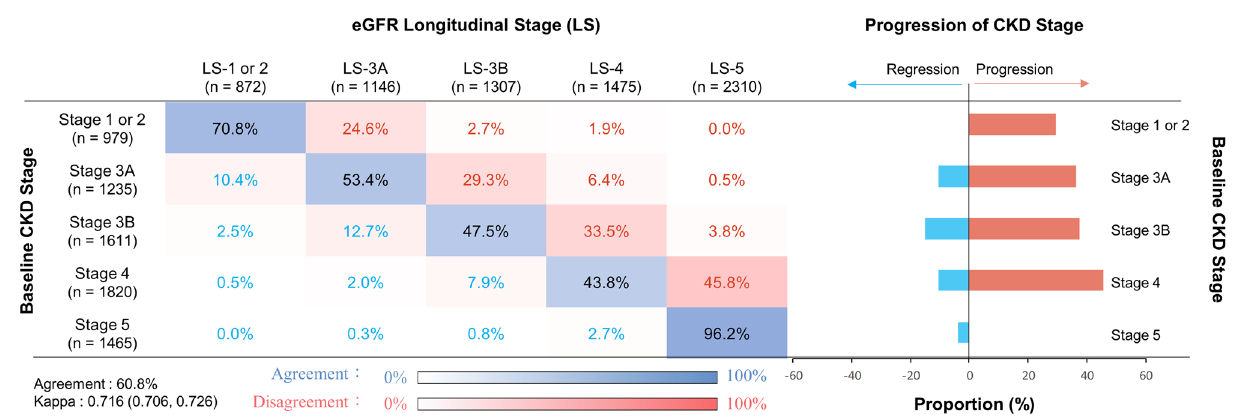
Figure 2. Concordance of baseline CKD stage and longitudinal stages of eGFR ing eGFR LSs was observed, which was opposite to the trend of the baseline prevalence of diabetes and hyper- tension. At baseline, nonsteroidal anti-inflammatory drug (NSAID) exposure was relatively prevalent, ranging from 21.9 for eGFR LS-5 to 28.6% for eGFR LS-3A. For exposure to radiocontrast, it ranged from 6.2 for eGFR LS-1-2 to 11.5% for eGFR LS-4 (Table 1). Clinical characteristics by the responsiveness to pre‑ESRD program. Only 3.8% of patients showed improvement in eGFR LS over the follow-up in patients with baseline CKD stage 5 (Fig. 2). Further- more, the concordance matrix demonstrated a gradual increase in the proportion of CKD stage progression (LS more advanced than baseline CKD stage) with the increase in the baseline eGFR CKD stage (29.2% for stages 1–2; 36.2% for stage 3A; 37.3% for stage 3B; 45.8% for stage 4; Fig. 2). We then divided the study population based on the concordance between baseline CKD stage and eGFR LS into 3 groups: (1) Stage-Stable (4326, 60.8%); (2) Stage-Regression (617, 8.7%); and (3) Stage-Progression (2167, 30.5%). Patients in the Stage-Regres- sion and Stage-Progression groups had comparable baseline eGFR (36.7 vs. 33.5 mL/min/1.73 m 2 , P = 0.76; Table 2). However, patients in the Stage-Progression group had significantly higher baseline levels of serum blood urea nitrogen, phosphorus, total cholesterol, and uPCR along with significantly lower baseline levels of serum albumin, hemoglobin, and urine creatinine compared with those in the other groups (Table 2). Also, responsive patients were more likely to have been exposed to NSAIDs and have better baseline levels of S-Cre, blood urea nitrogen, SUA, phosphorus, and uPCR than nonresponsive patients (Table S2). The eGFR slopes before enrollment to pre-dialysis care were comparable between responsive and nonresponsive patients (− 6.97 vs. − 7.89 mL/min/1.73 m 2 /y). The eGFR slope was then flattened to 0.21 mL/min/1.73 m 2 /y among responsive patients, whereas the annual eGFR slope kept declining at − 5.34 mL/min/1.73 m 2 /y in nonresponsive patients